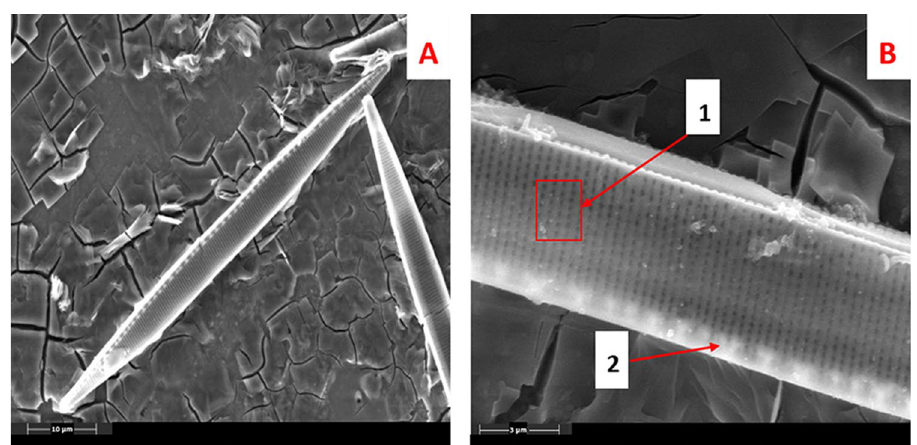
Figure 3. ( A ) SEM image of acid digested cell of Diatom Nitzschia sp. showing its frustule; ( B ) Magnified view of frustule surface showing it characteristic feature Striae, and Fibulae marked as 1 and 2